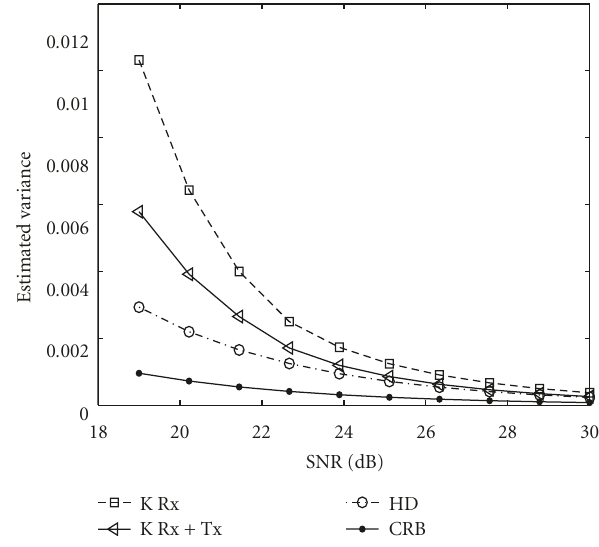
Figure 6: Estimated variance for the estimates of the position of target 2 versus SNR corresponding to the location under Born- approximable conditions of two targets located at X 1 = ( X 1 = = − 6) and X = ( X = 1, Y = − 6) (refer to the caption of − 1, Y 1 2 2 2 Figure 5 for details applicable also to this